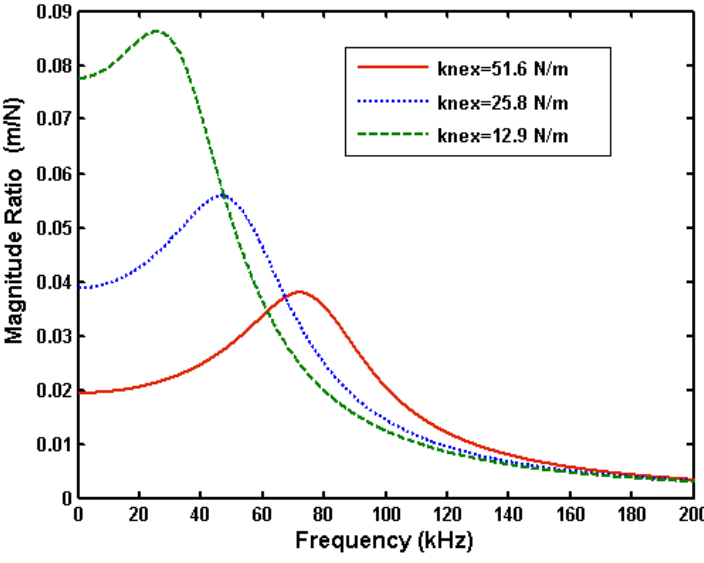
Figure 3. Effect of leg stiffness on frequency response of square plate resonator with 67 μ m × 67 μ m hole at atmospheric pressure.